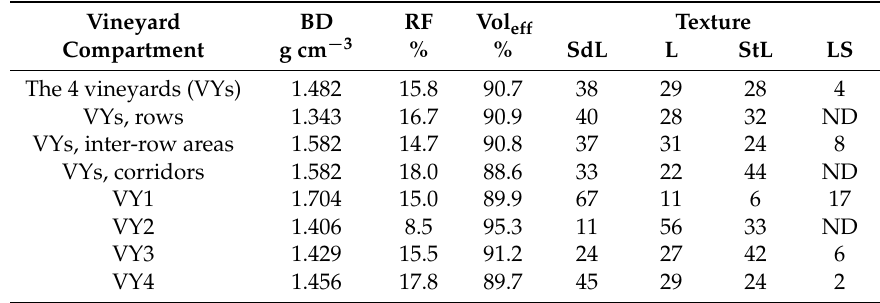
Table 1. Bulk density (BD), rock fragments (RF), effective volume (Vol eff ) and soil texture in the three vineyards’ compartments and the four fields. Vineyard BD RF Vol eff Texture Compartment g cm − 3 % % SdL L StL The 4 vineyards